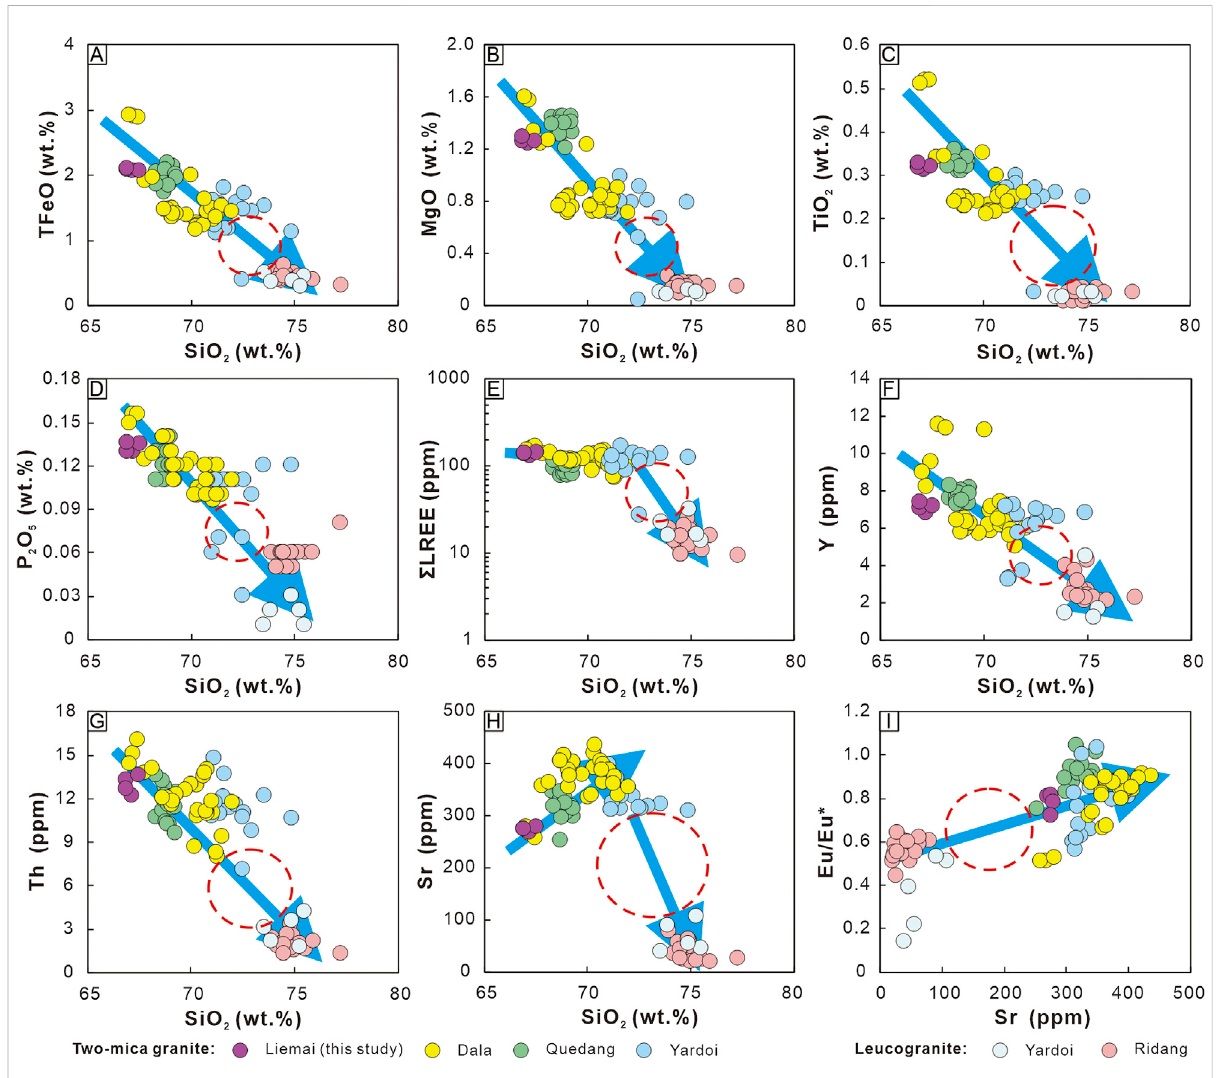
FIGURE 12 (A) TFeO, (B) MgO, (C) TiO 2 , (D) P 2 O 5 , (E) Σ LREE, (F) Y, (G) Th, (H) Srvs. SiO 2 ,and (I) Eu/Eu*vs. Srdiagrams for theLiemai two-micagranite.Data source: the granites and leucogranites are the same as in Figure 5. The red dotted circle denotes the compositional gaps between the two-mica granites and the